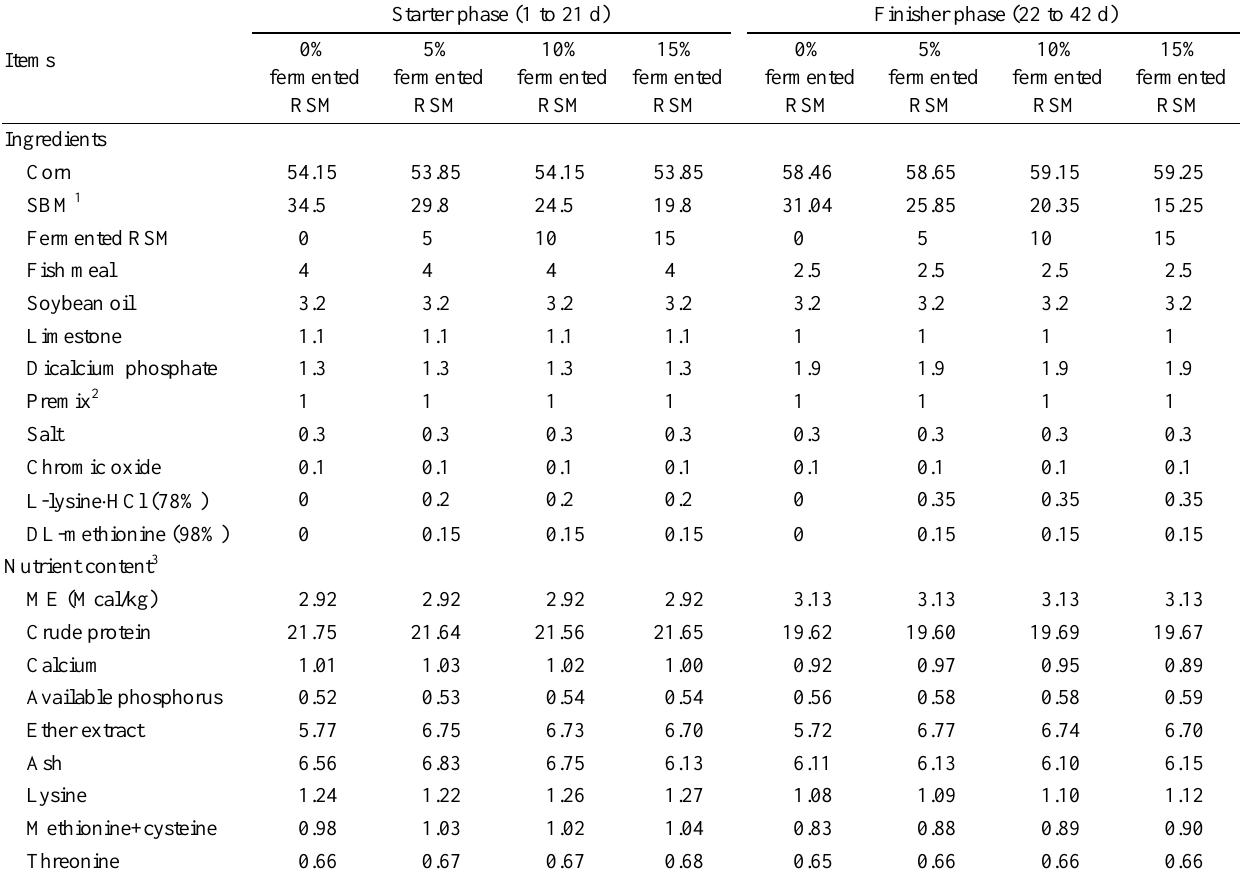
Table 1. Ingredient composition and nutrient content (%, as fed basis) of experimental diets